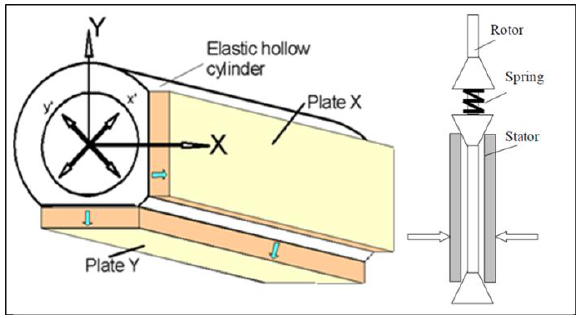
Figure 10. Metal tube piezoelectric ultrasonic motor [34].